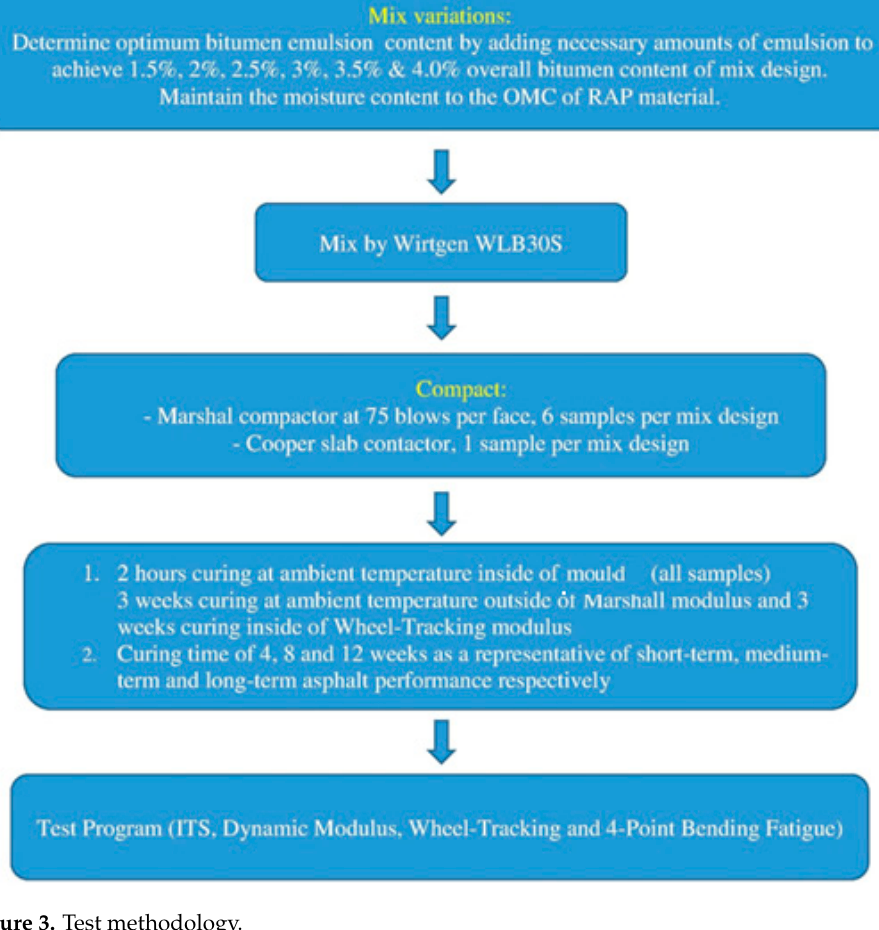
Figure 3. Test methodology.